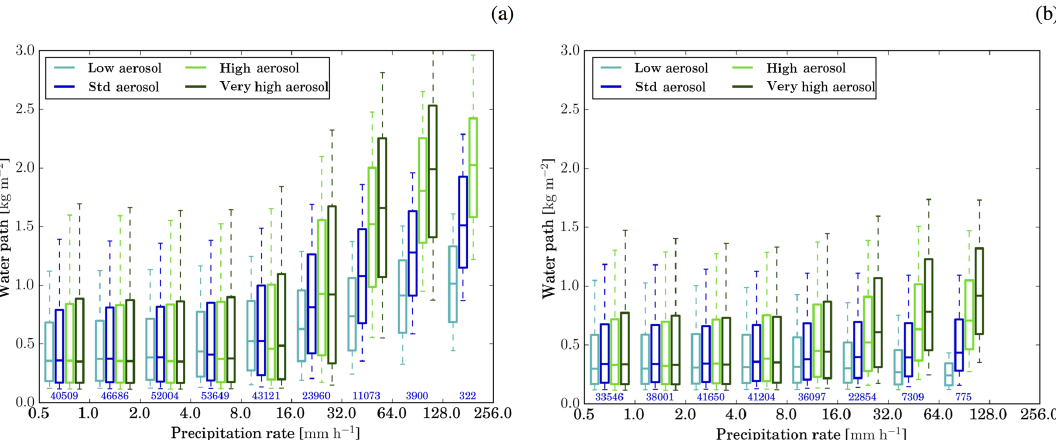
Figure 7. The box and whisker plots show the distribution of the condensed water path (cloud and ice categories) in columns with certain precipitation rates for simulations with (a) passive aerosol and (b) aerosol processing. Different colours correspond to the different aerosol profiles. Values are only shown for precipitation bins with more than 100 data points. The median water path is shown by the horizontal line in the box. The boxes cover the interquartile range (25th to 75th percentile) and whiskers represent the 10th and 90th percentile, respectively.